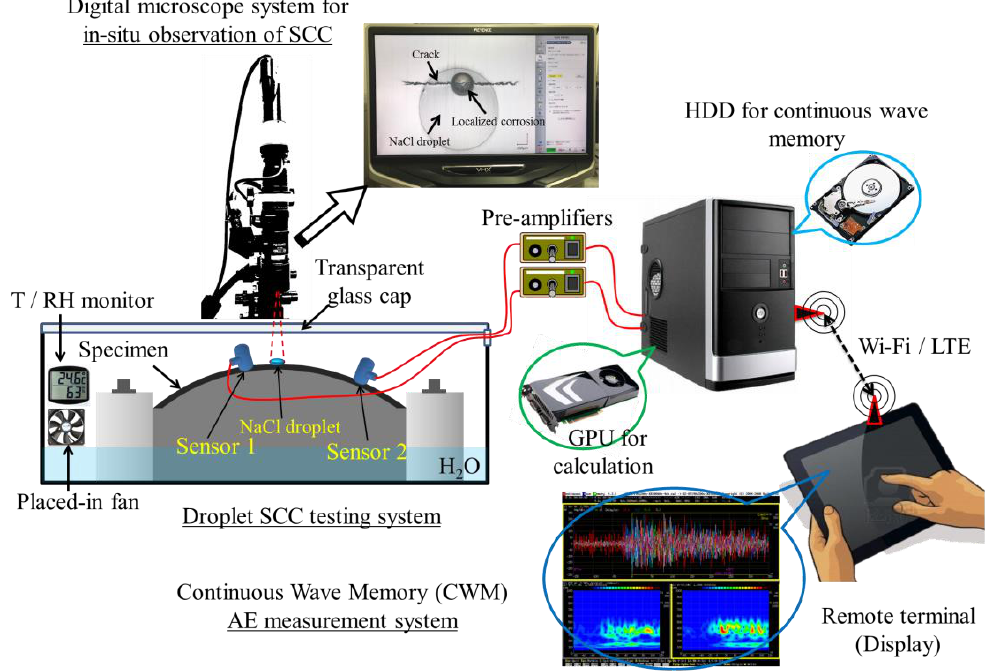
Figure 1. Schematic of the modified stress corrosion cracking (SCC) test system incorporated with an in-situ digital microscope and acoustic emission (AE) measurement systems. Online version in color.